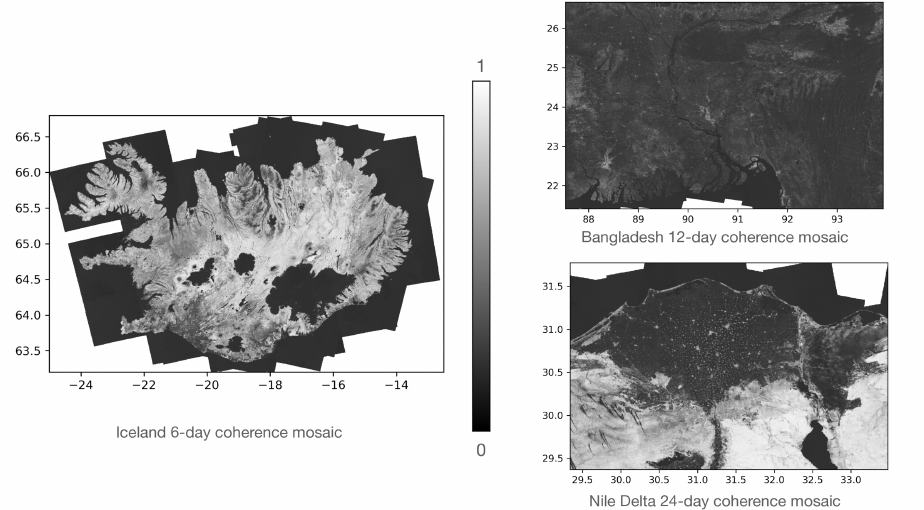
Figure 4. Example of coherence mosaics from our global InSAR product. ( Left ) Six day coherence mosaic from over Iceland, 6–10 July 2020. ( Right-top ) Twelve day coherence mosaic, 3–15 May 2021, over Bangladesh. ( Right-bottom ) Twenty-four day coherence mosaic, 3–26 May 2021, over the Nile Delta in Egypt.